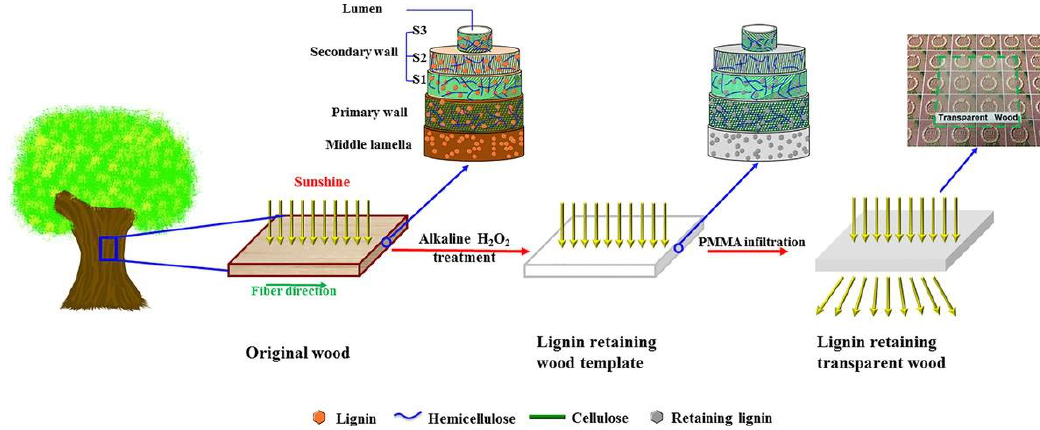
Figure 6. Schematic of process of obtaining transparent wood by lignin modification followed by PMMA infiltration. Reprinted with permission from [31], copyright 2017, John Wiley & Sons.